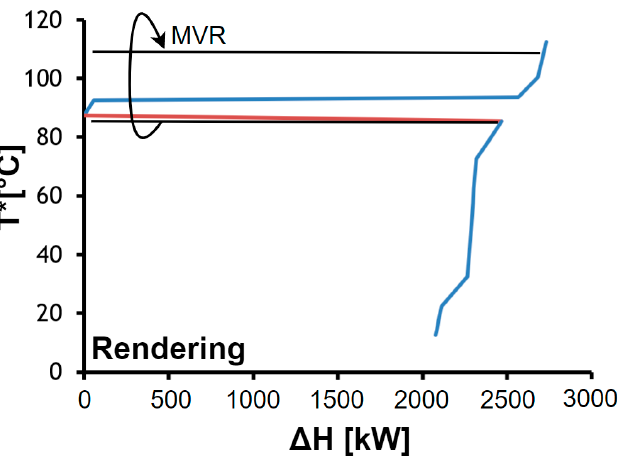
Figure 5. ( a ) Total Site Plot, the red coloured lines on the Gross cold utility use side of the plot, represent process streams that require cooling, and the blue colored lines represent the cold utility streams that would be required to carry out this cooling. The blue colored lines on the Gross hot utility use side of the plot represent process streams that require heating, and the red colored lines represent the hot utility streams that would be required to carry out this heating; ( b ) SUGCC of current site utilities. Red colored lines represent hot utilities, and blue colored lines represent cold utilities. T** referring to twice shifted temperature.